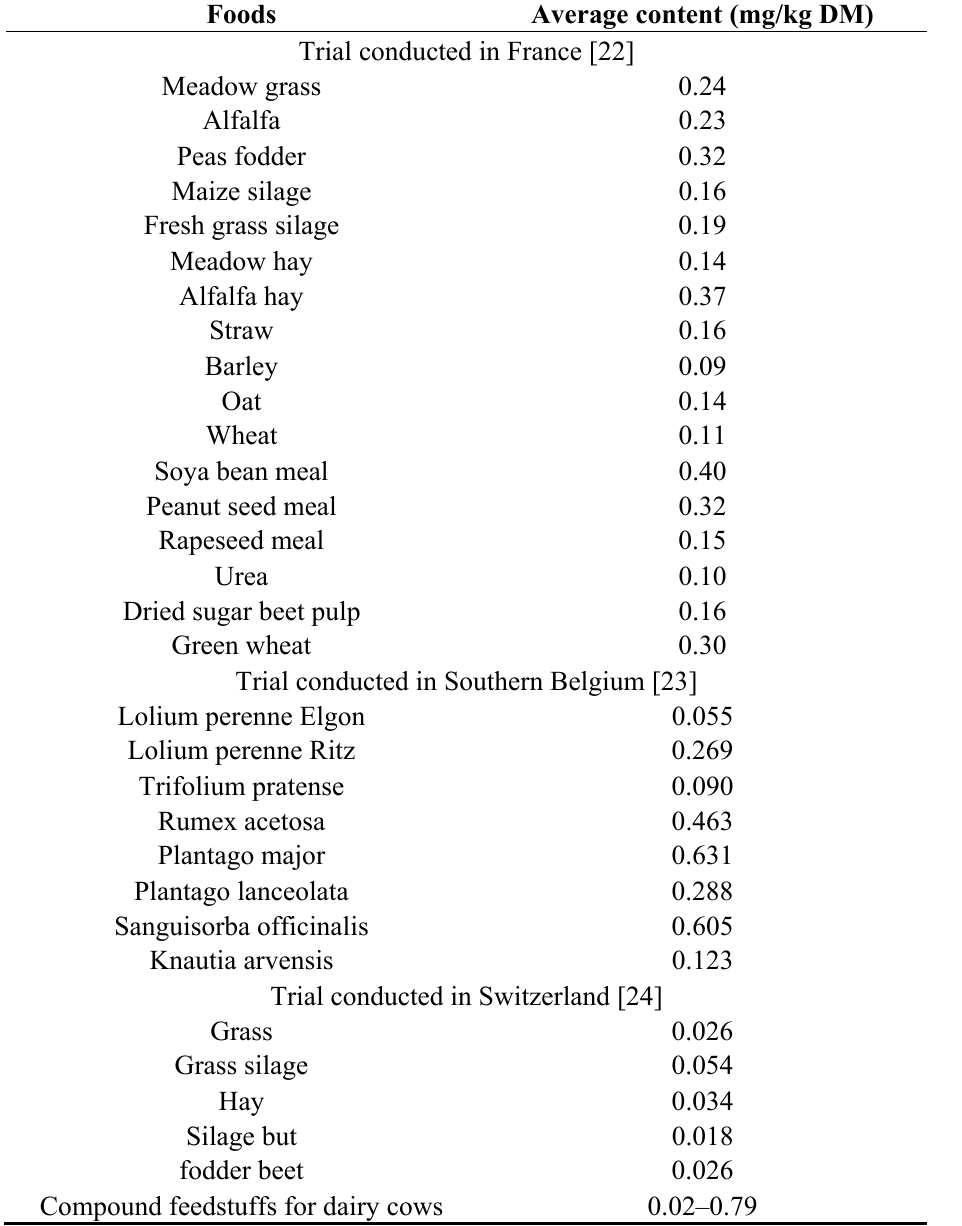
Table 1. Selenium content of various animal